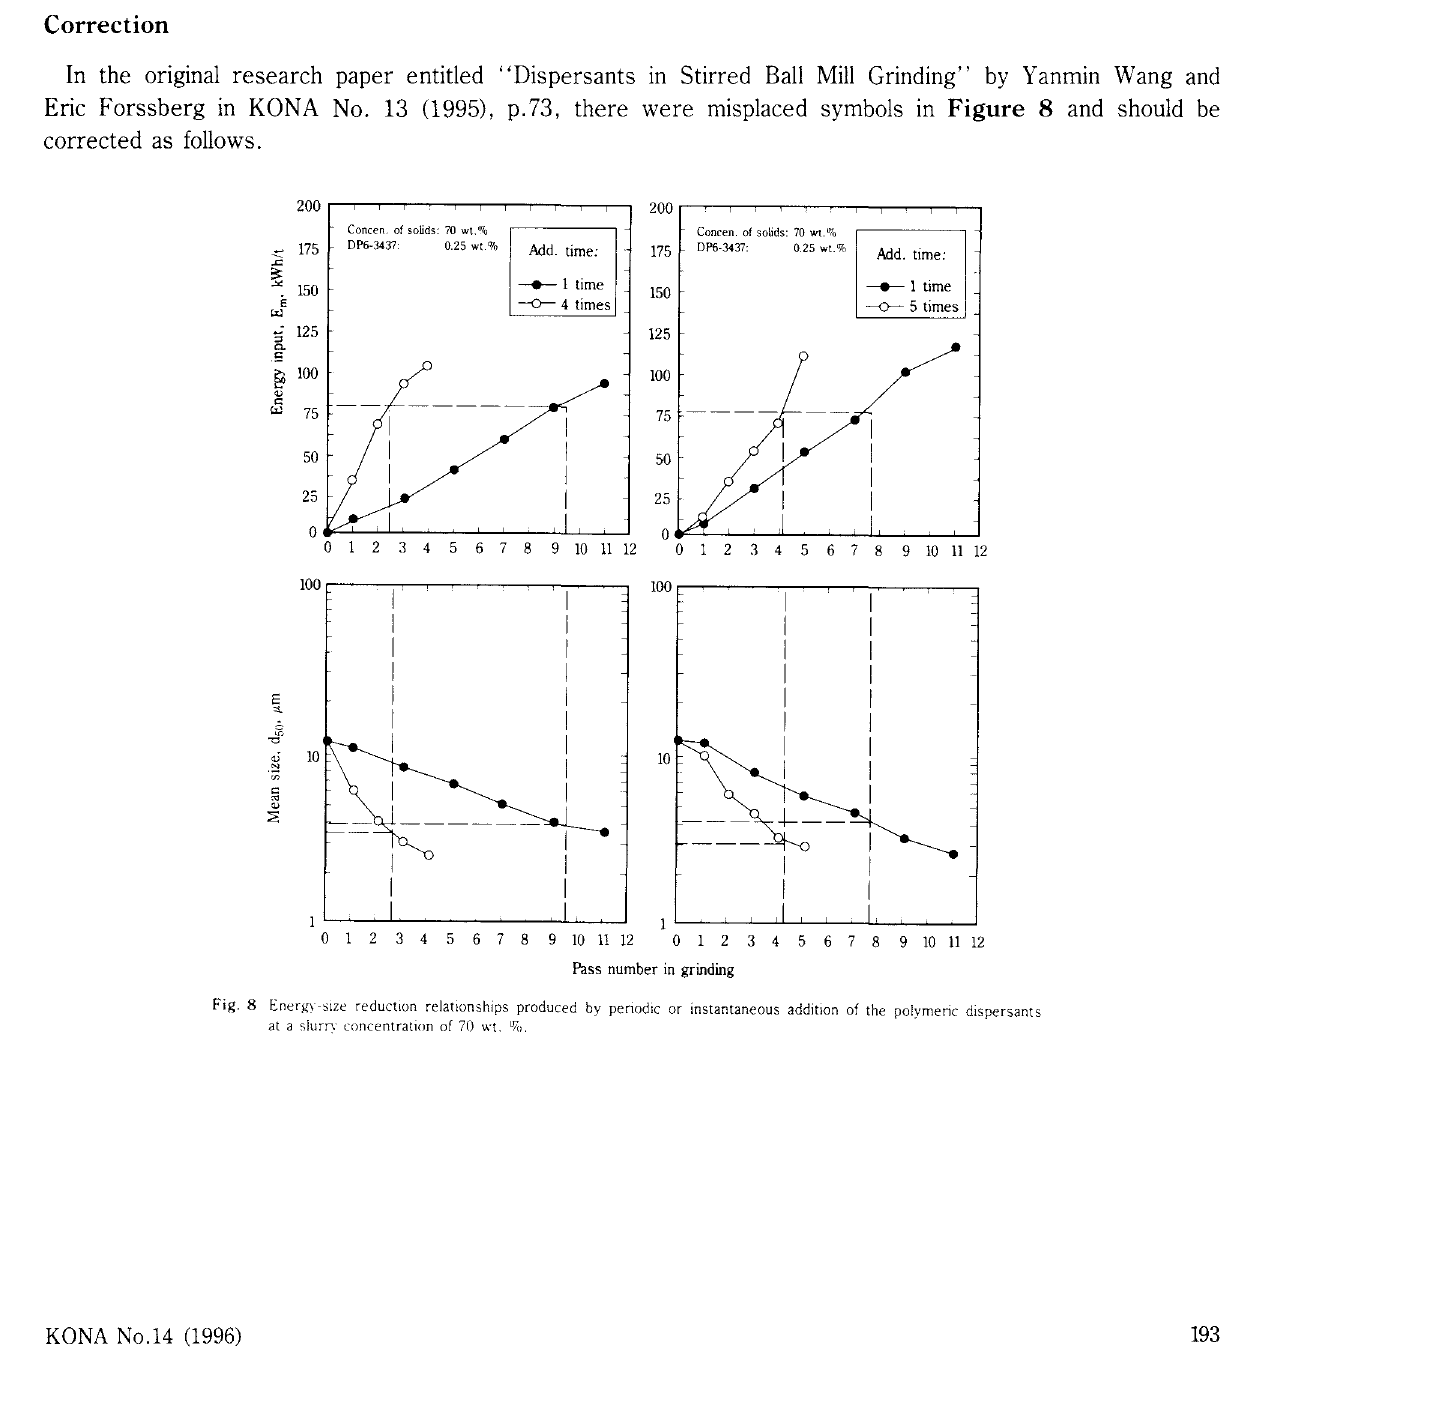
Fig. 8 Energ:; -s1ze reductton relat!onsh1ps produced by penod1c or instantaneous addit1on of the polymeric dispersants at a slurry concentrat10n of 70 wt. t.rC1.